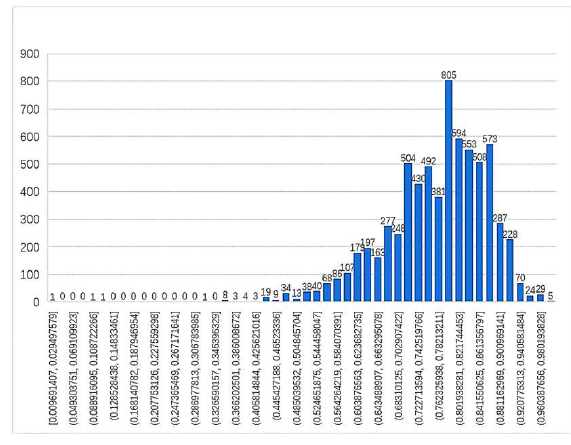
Figure 12. Distribution histogram of evaluation index values of multi-word geographical names.